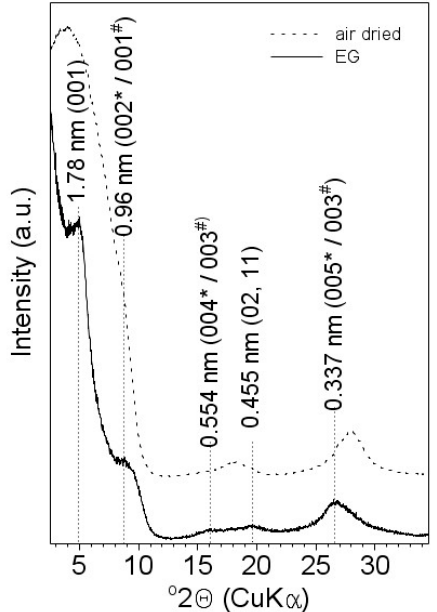
Figure 2. XRD patterns of the oriented clay fraction sample <2 µm. Non-rational basal reflections in the EG treated pattern with contributions from saponite (*) and turbostratic talc ( # ) are indicated.